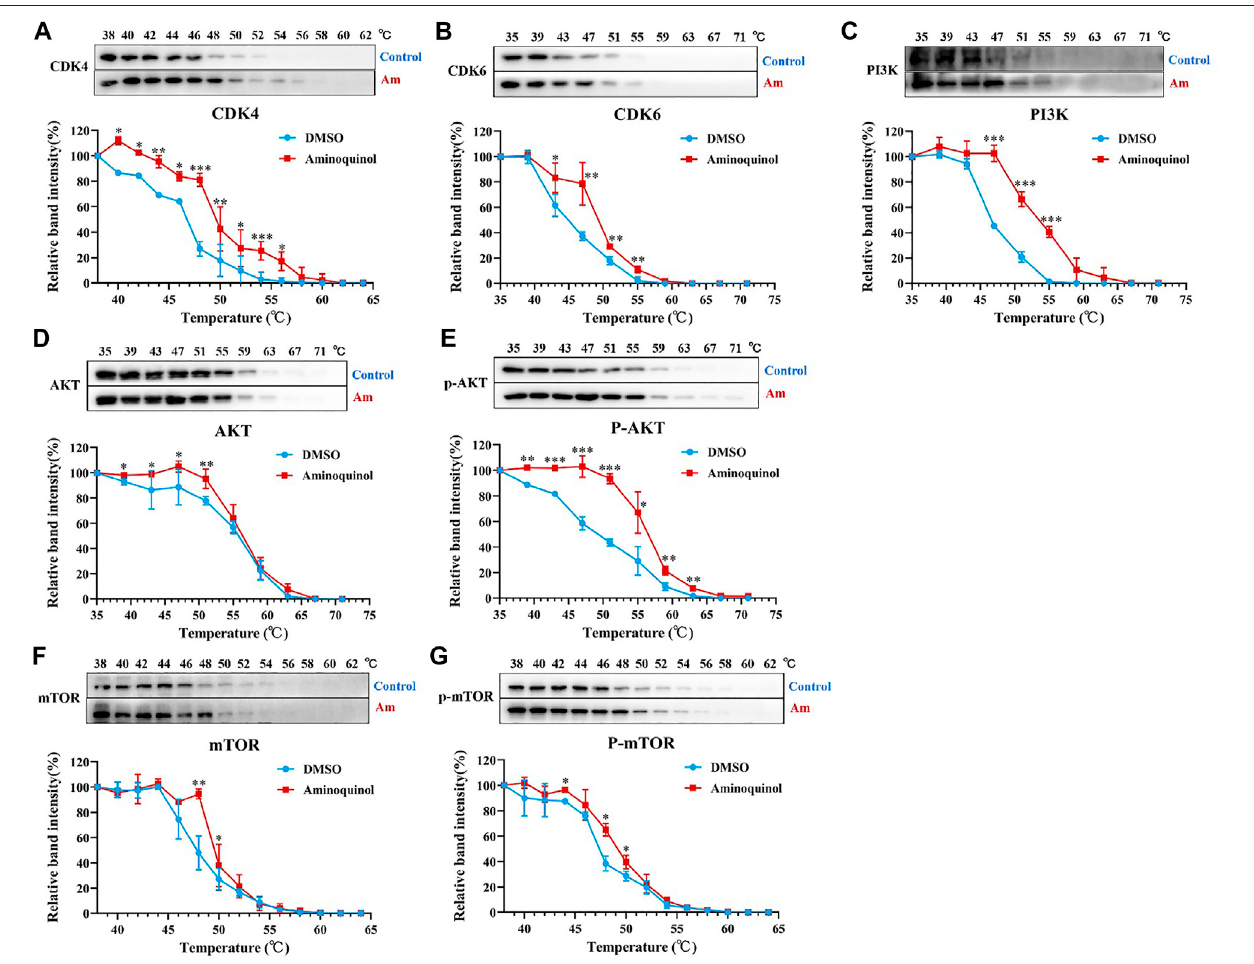
FIGURE 6 | Thermal proteome pro fi ling (TPP) analysis suggested the binding of aminoquinol with CDK4/6, PI3K and p-AKT in Huh7 cells. Huh7 cell lysate was treated with aminoquinol (100 μ M) or vehicle (DMSO) for 20 min and incubated at temperatures ranging from 35 to 75 ° C. Proteins from each fraction were analyzed via western blotting. Quanti fi cation was based on the intensity of bands. Thermal denaturation curves were obtained from all proteins in control (blue) and aminoquinol- treated (red) samples (A – C, E) The representative pictures of western blotting and thermal denaturation curves of (A) CDK4, (B) CDK6, (C) PI3K and (E) p-AKT, indicating thermal stabilization (D, F – G) The thermal stability of (D) AKT, (F) mTOR and (G) p-mTOR, indicating weak increases in thermal stability. All experiments were performed in triplicate, and data were given as the AVE ± SEM. * p < 0.05, ** p < 0.01, *** p < 0.001, signi fi cantly different from the control group.